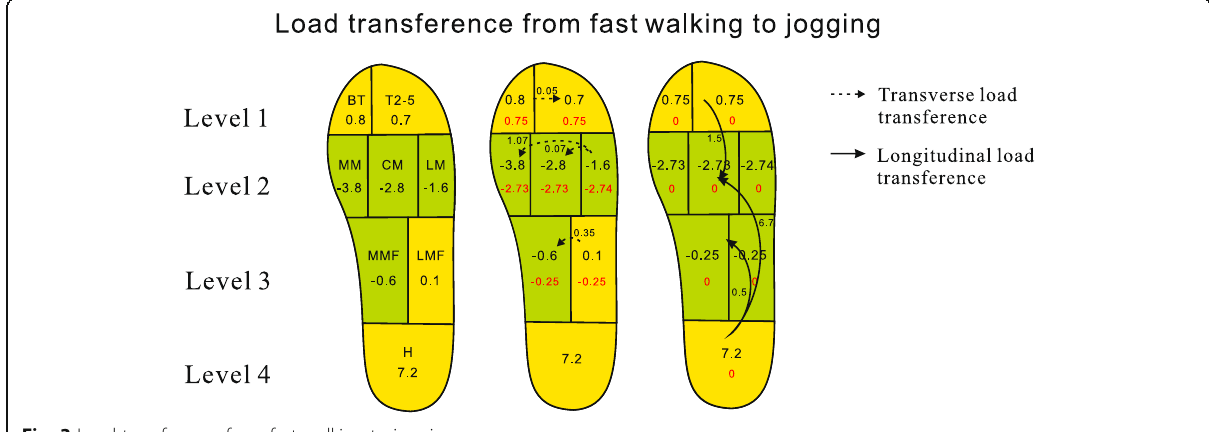
Fig. 3 Load transference from fast walking to